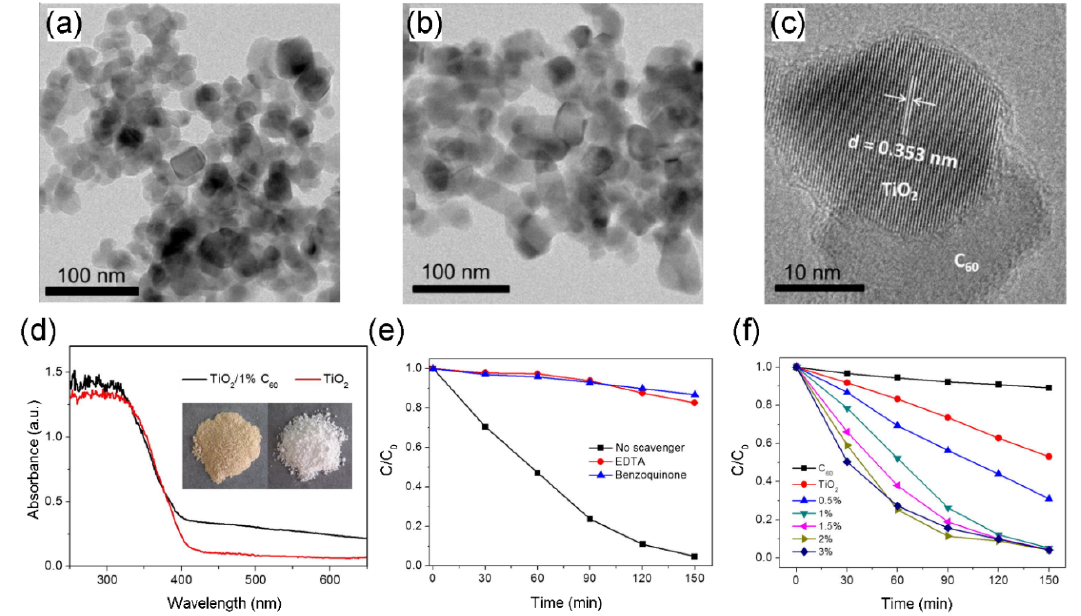
Figure 2. TEM images of TiO 2 ( a ) and TiO 2 / C 60 ( b ). ( c ) HR-TEM image of TiO 2 / C 60 . ( d ) Diffuse reflectance spectroscopy (DRS) of TiO 2 / C 60 and pure TiO 2 . ( e ) Free radical capture experiment